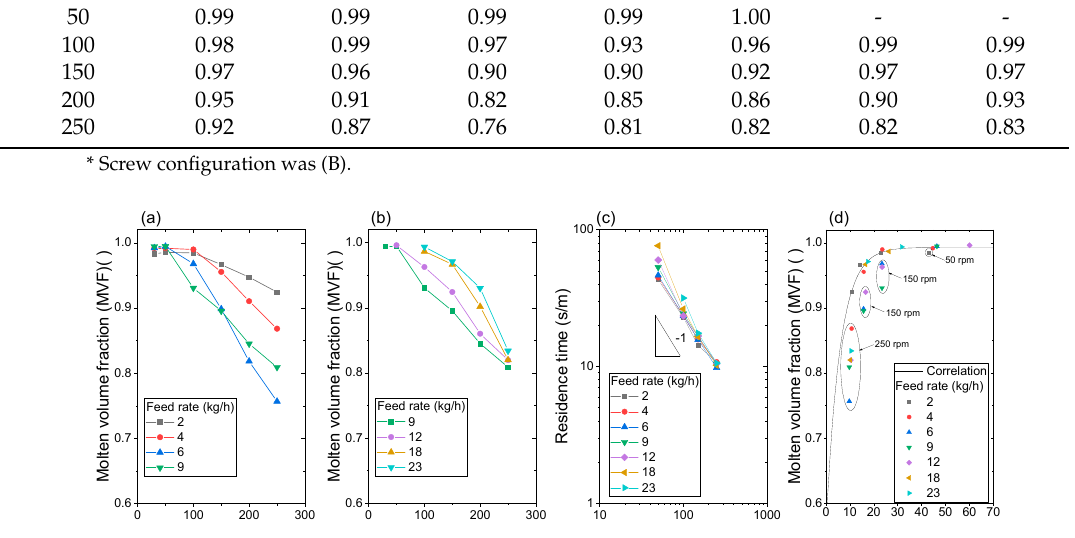
Table 3. Summary of molten volume fraction (MVF) dependence on increasing feed rate at a con- stant screw rotation speed: 2nd series *.